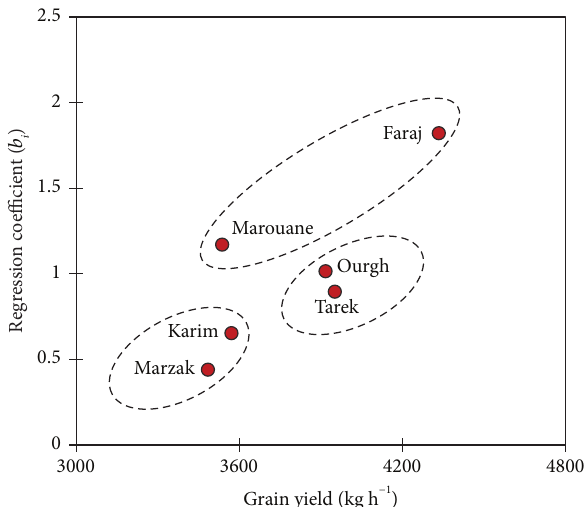
Figure 4: Relationship between regression coefficient ( b i ) and average grain yield of six Moroccan durum wheat varieties grown under two water regimes during three growing seasons.